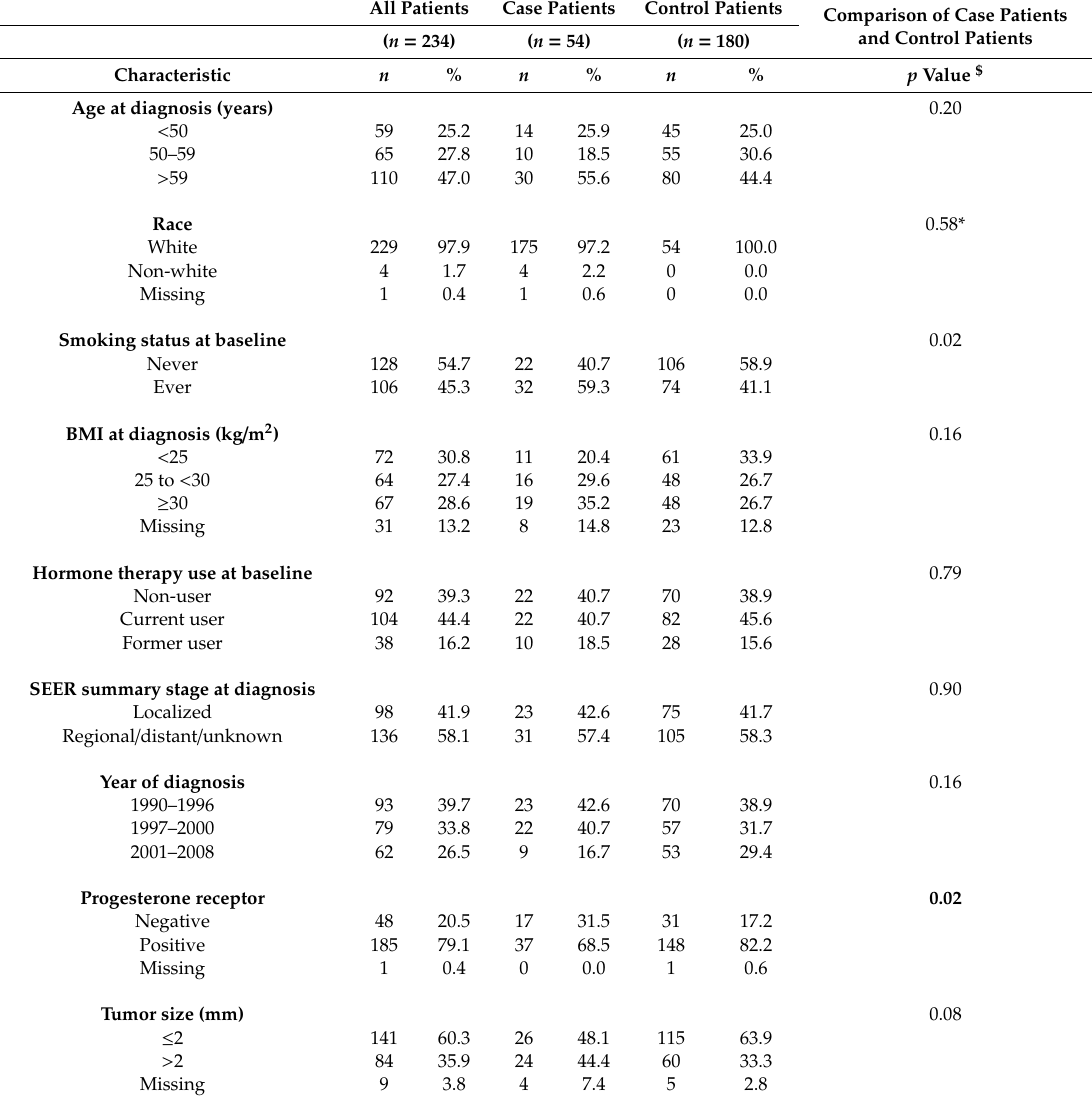
Table 1. Selected patient and tumor characteristics among ER-positive breast cancer patients treated with tamoxifen with available adjacent normal tissue blocks for TDLU